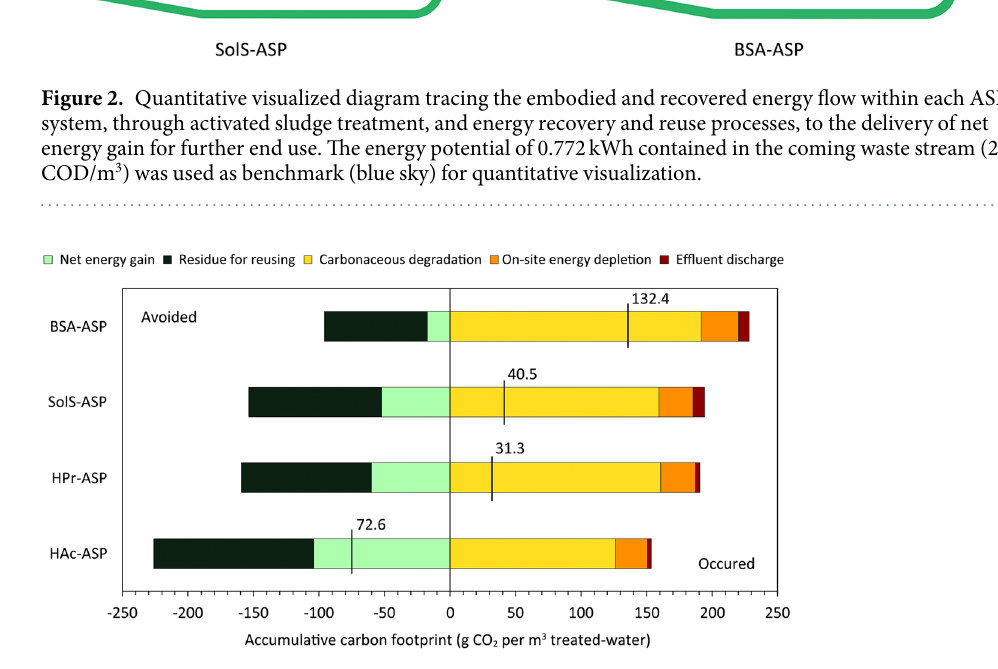
Figure 3. Accumulative carbon footprint for integrating wastewater treatment with expanded energy capture in all four ASPs. The green color series indicate the carbon emission avoided from bioenergy production, while the orange color series represent the carbon emission that occurred, including carbonaceous degradation in the ASPs, energy depletion for system maintenance, and also effluent discharge. Note that the black vertical segment presents the net carbon emission of the system boundary considered in each